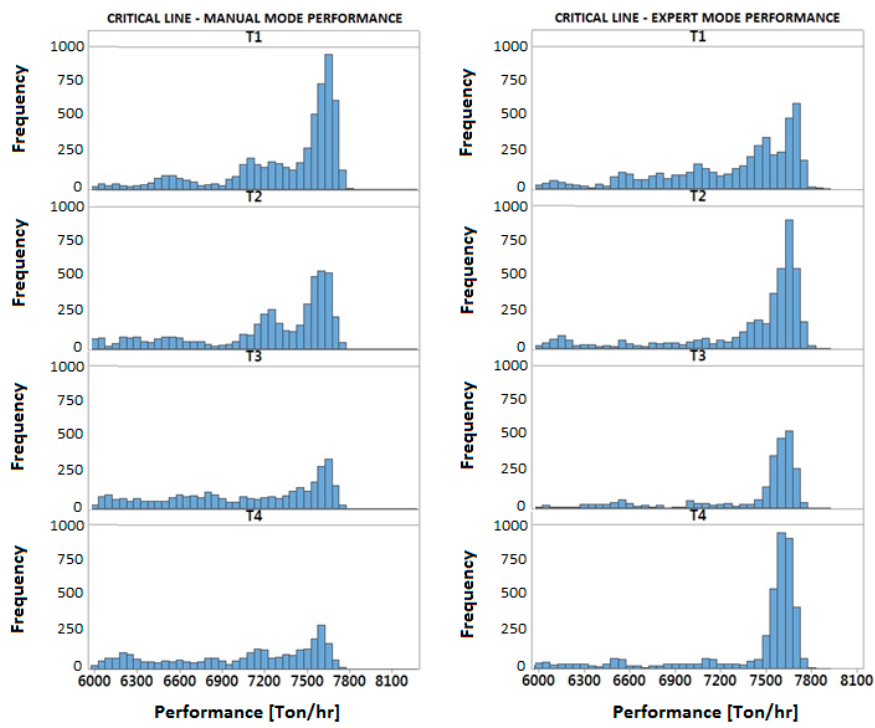
Figure 5. Frequency of data, both modalities by turns.